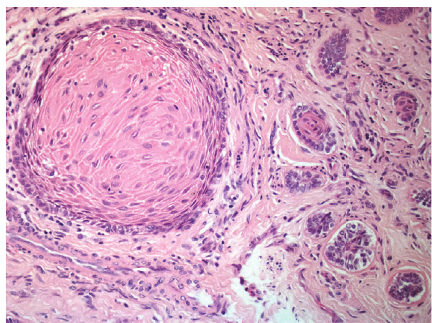
Figure 7: Desmoplastic